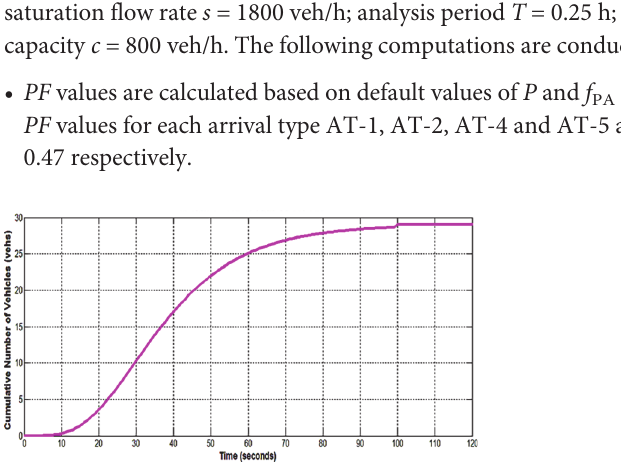
Fig 11. Cumulative platoon arrival profile from